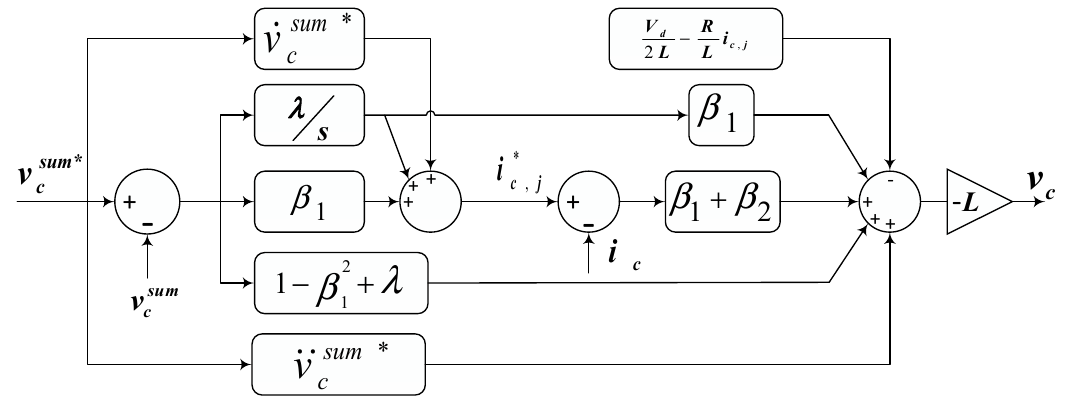
Figure 4. Structure of design controller.